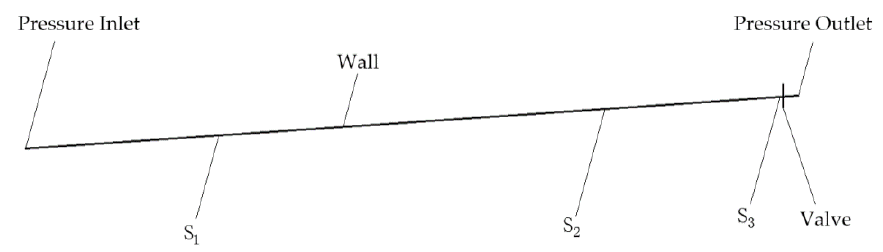
Figure 2. Sketch of the geometry model.